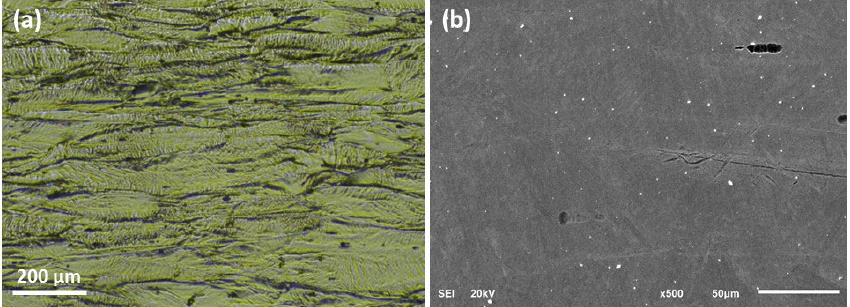
Figure 2. ( a ) Optical and ( b ) SEM images of the as ‐ received cold rolled UN08029 alloy showing the deformed columnar grains.